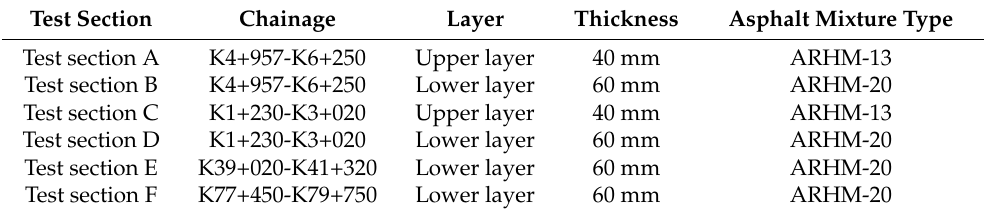
Table 1. Test section